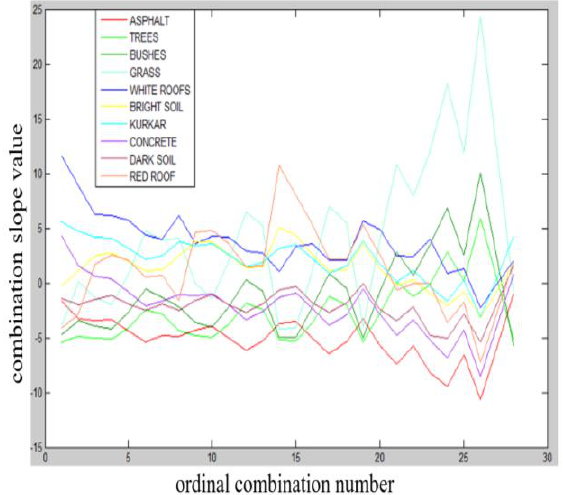
Figure 4. mean spectral signature in slope